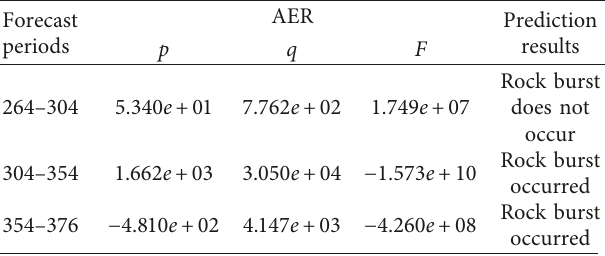
Table 6: Rock burst prediction of cylindrical